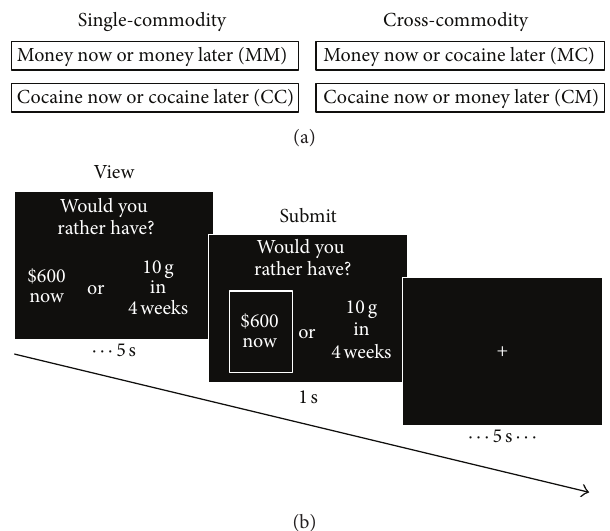
Figure 1: Behavioral tasks. Participants performed two single- commodity and two cross-commodity temporal decision-making tasks. (a) During single-commodity tasks individuals made choices between immediate money or delayed money (MM) and immediate cocaine or delayed cocaine (CC). In cross-commodity tasks individ- uals made choices between immediate money or delayed cocaine (MC) or between immediate cocaine or delayed money (CM). (b) An example trial from the MC task. A trial consisted of a viewing period lasting for a maximum of 5 s, a submission period lasting for 1s, and a jittered fixation screen lasting for an average of 5 s. During the viewing period immediate and delayed options appeared randomly on the left or right side of the screen under the question, “Would you rather have?” Once individuals selected the immediate or delayed commodity a box appeared around their selection for 1s. Immediate amounts were varied 6 times for each of four future time points (1, 4, 26, and 52